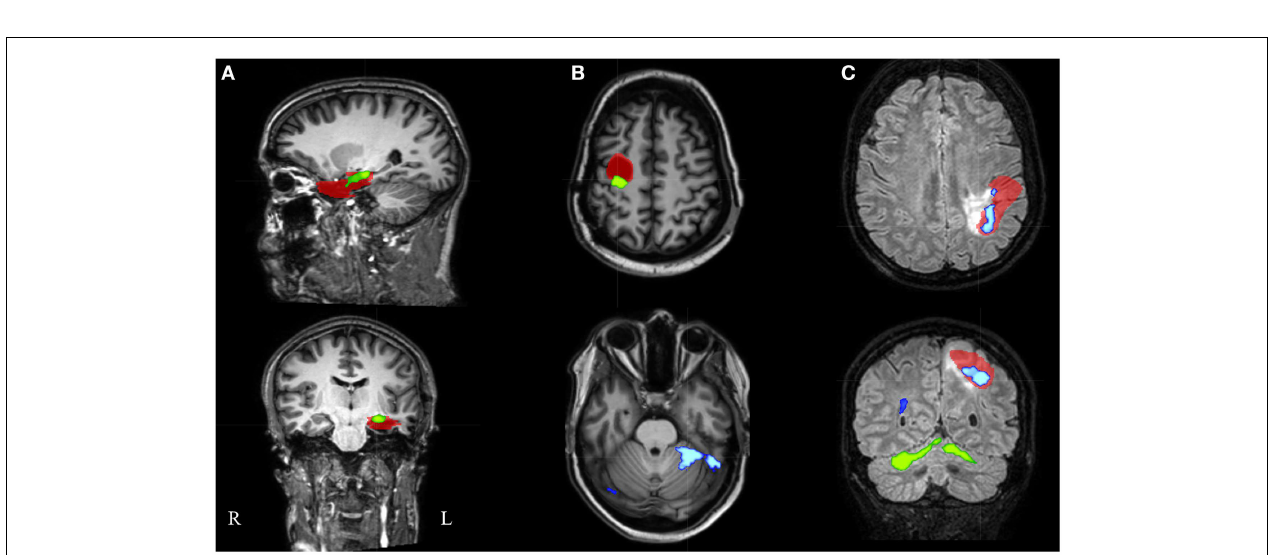
FIGURE 4 | Electroencephalography-functional magnetic resonance imaging activations are overlaid on representative slices of the postsurgical structural image of patient 3 (A) after thresholding at an uncorrected p < 0.001 ( Z = 3.1, no constraint on cluster size) and (B) at a FWE corrected p < 0.05 ( Z = 5.1, no constraint on cluster size) . (A) The EEG-fMRI cluster containing the maximal significant activation (green colored) is overlapping the IOZ (red colored).Widespread additional